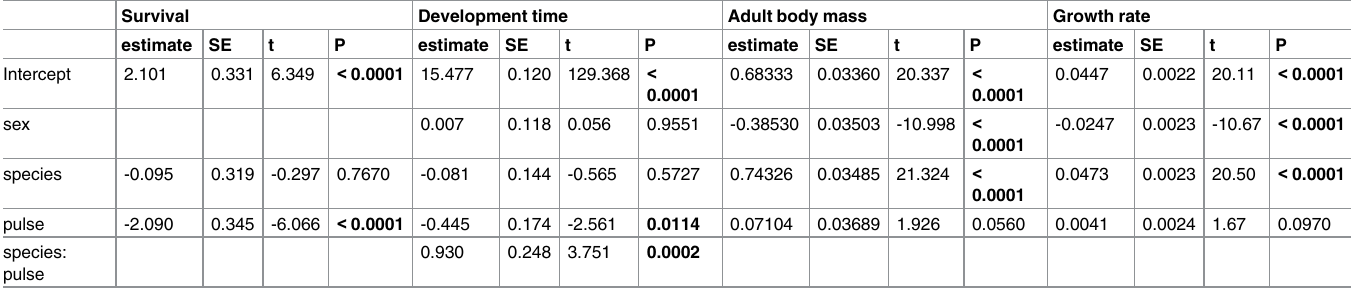
Table 4. Generalized linear model coefficients for life history traits of P . xylostella and D . semiclausum in experiment 2.